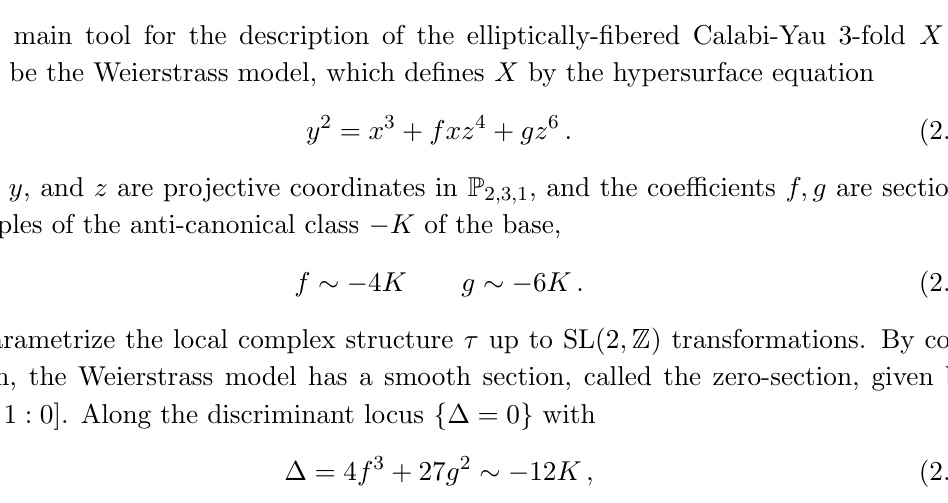
Table 1 . Kodaira-Tate classi(cid:12)cation of singular (cid:12)bers and local gauge